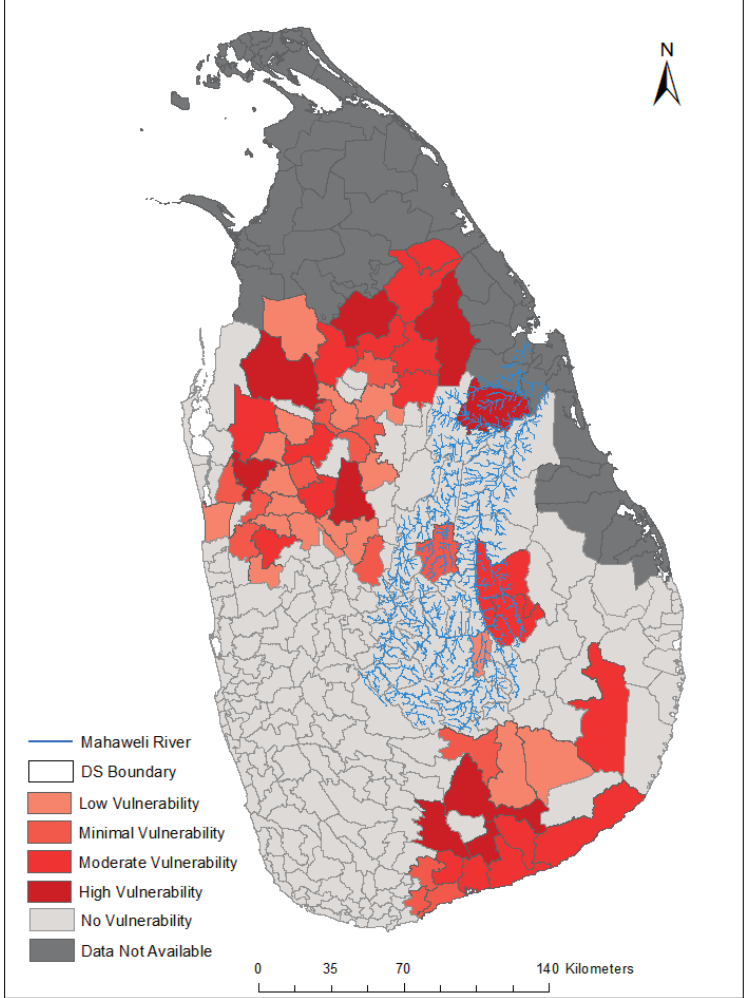
Figure 6. Irrigation sector vulnerability to drought